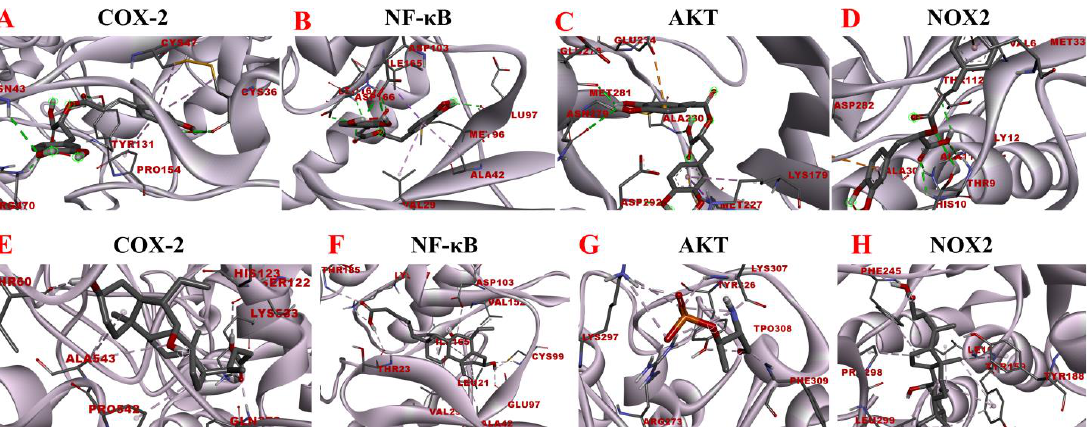
Figure 12. Molecular docking analysis of rosmarinic acid and obeticholic acid binding to COX-2, NF- κB, AKT and NOX2. ( A – D ) correspond to the binding models of rosmarinic acid with COX-2, NF- κB, AKT and NOX2, respectively. ( E – H ) correspond to the binding models of obeticholic acid with Nrf2, Keap1, HO-1, GSH-Px and GST, respectively. Table 6. Intermolecular interactions between rosmarinic acid and COX-2, NF- κB, AKT, and NOX2. Proteins